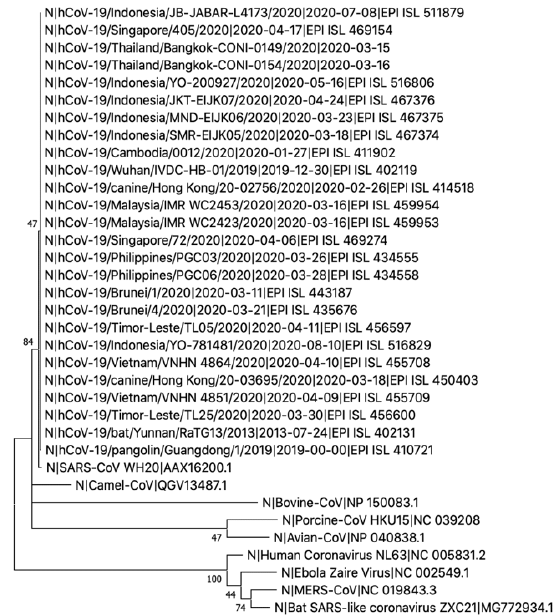
Figure 2. Phylogenetic tree generated to show the evolutionary relationship between the SARS-CoV-2 virus with the other types of coronaviruses that had been emerged in the past decades. the MEGA X software was utilized to generate the maximum- likelihood phylogenetic